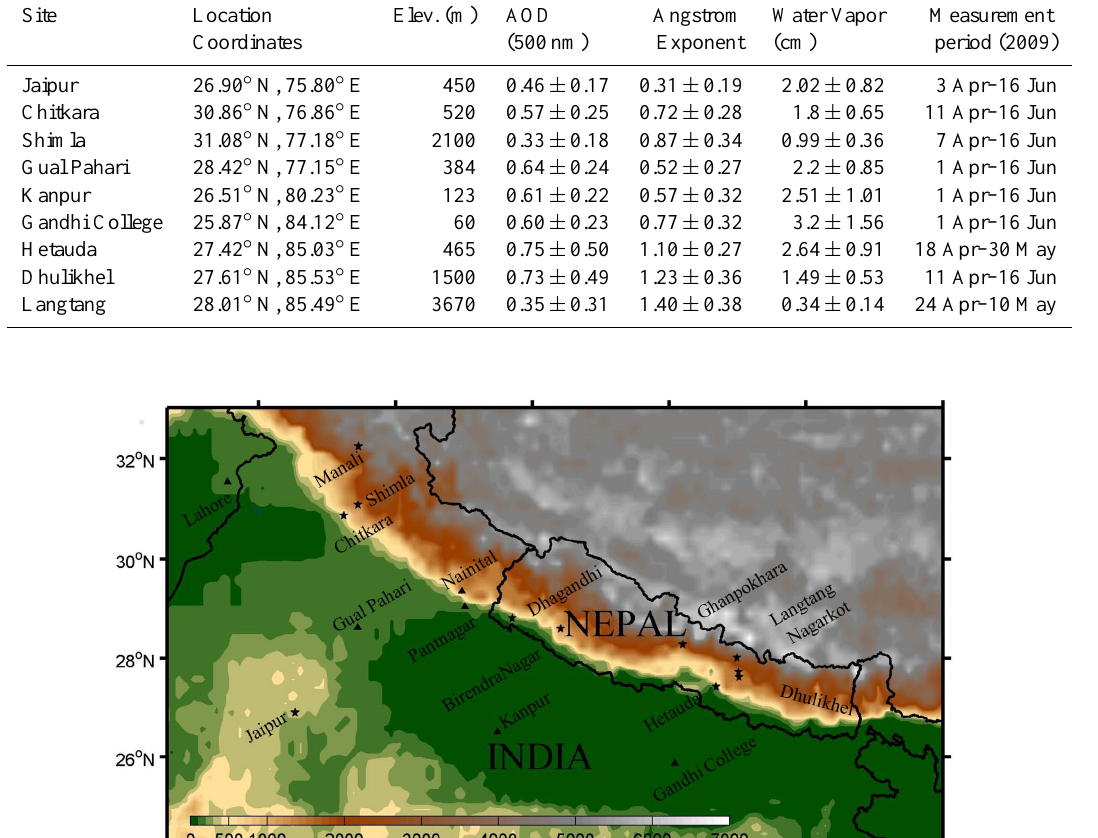
Table 1. Mean values (and standard deviation) of Aerosol Optical Depth, Angstrom Exponent and Water Vapor, for the measurement period during 2009, over various measurement sites at near-Desert (Jaipur), Indo-Gangetic Plains (Gual Pahari, Kanpur, Gandhi College) and foothill/slope stations (Chitkara University, Shimla, Hetauda, Dhulikhel and Langtang). Site information including coordinate and elevation is also listed for each site.